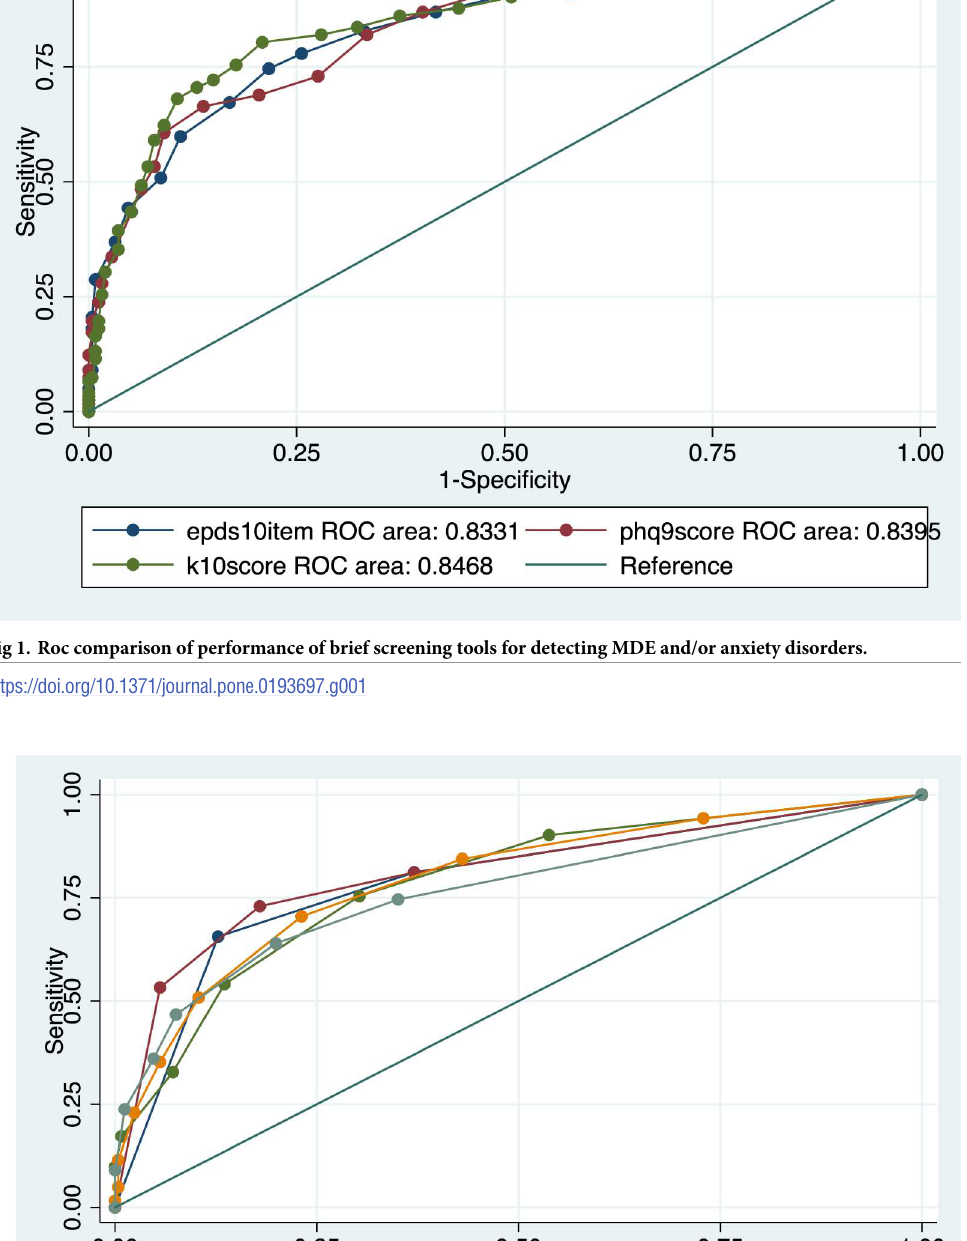
PLOS ONE | https://doi.org/10.1371/journal.pone.0193697 April 18,